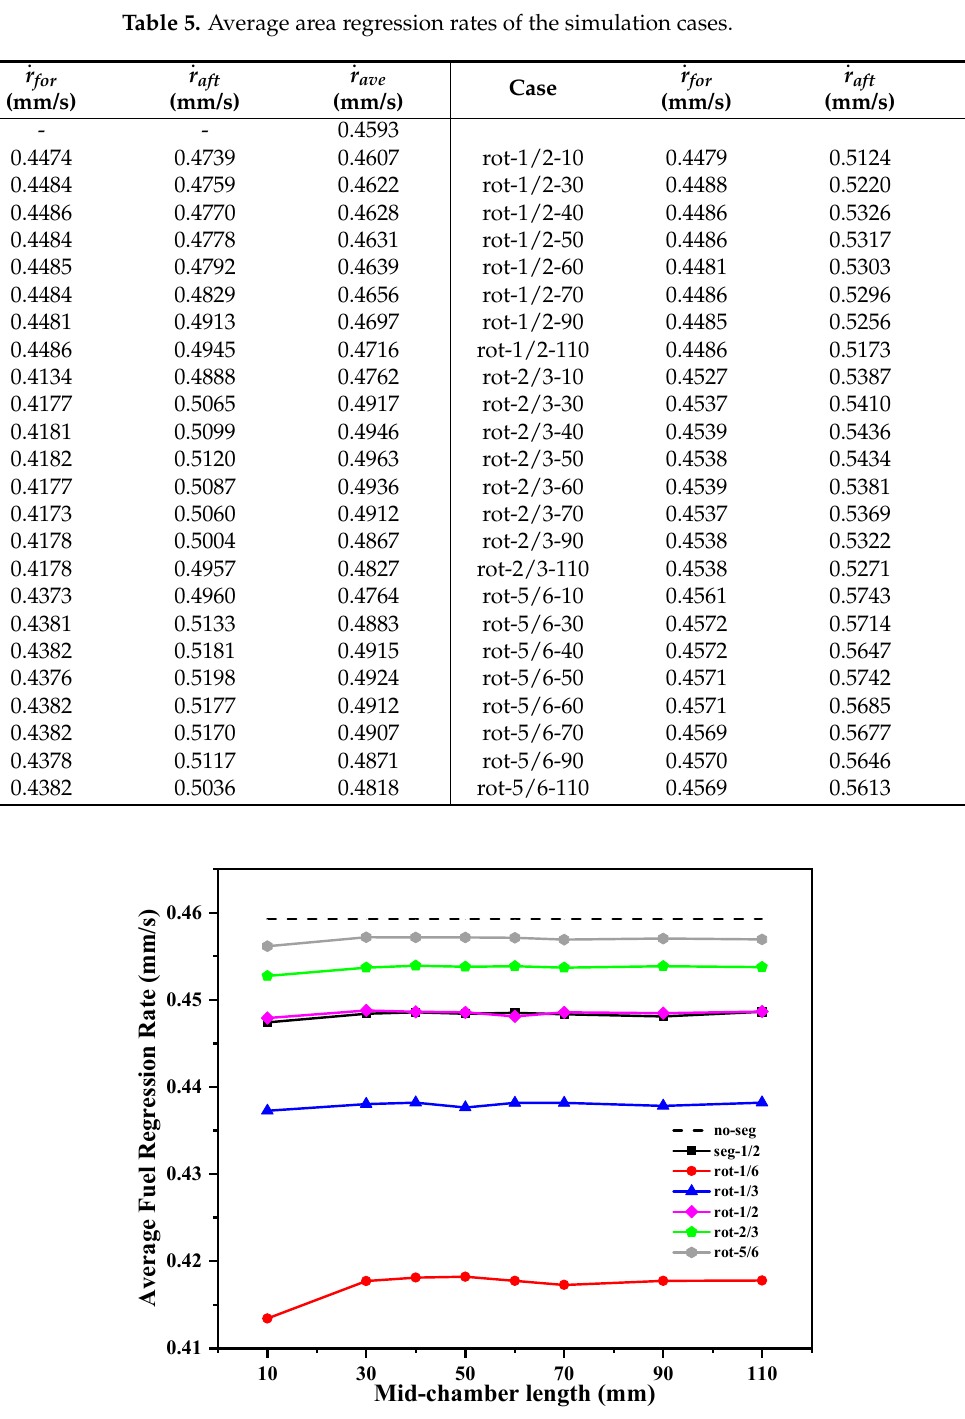
Figure 25. Average fuel regression rates in the fore-section grain for various cases.